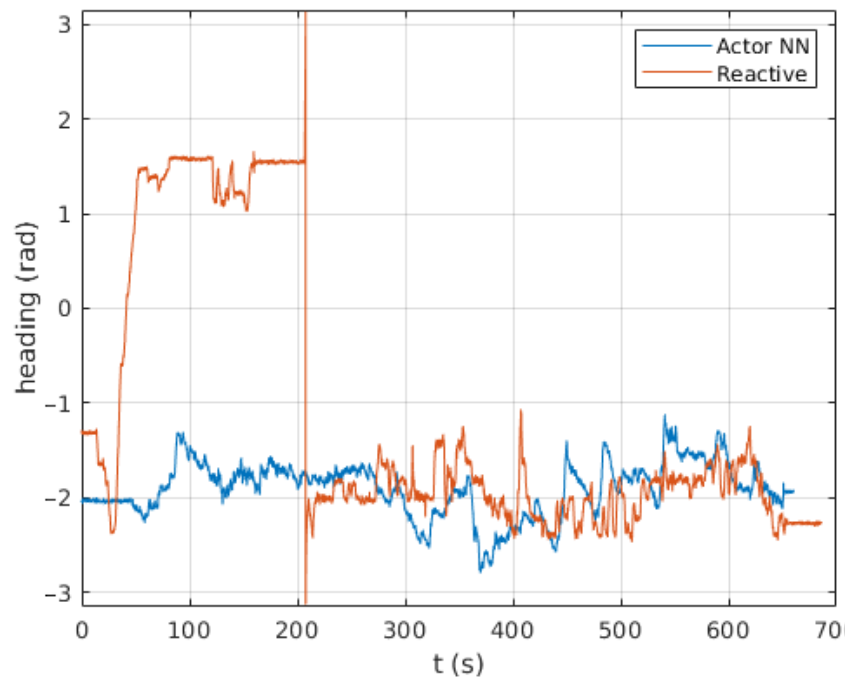
Figure 23. Heading changes along time with the reactive and the Actor NN